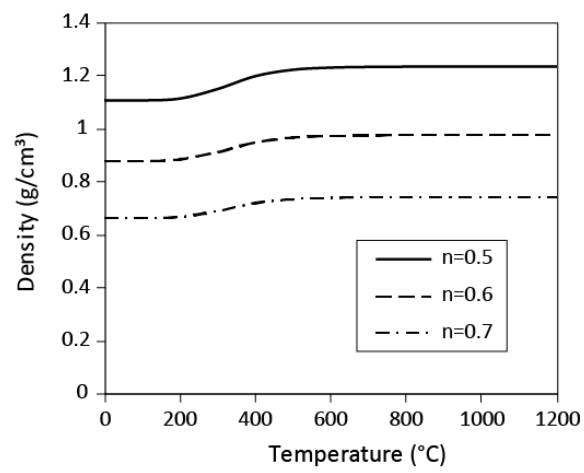
Figure 5. Temperature dependent densities of the growing medium according to porosities ( n ) 0.5, 0.6, and 0.7.